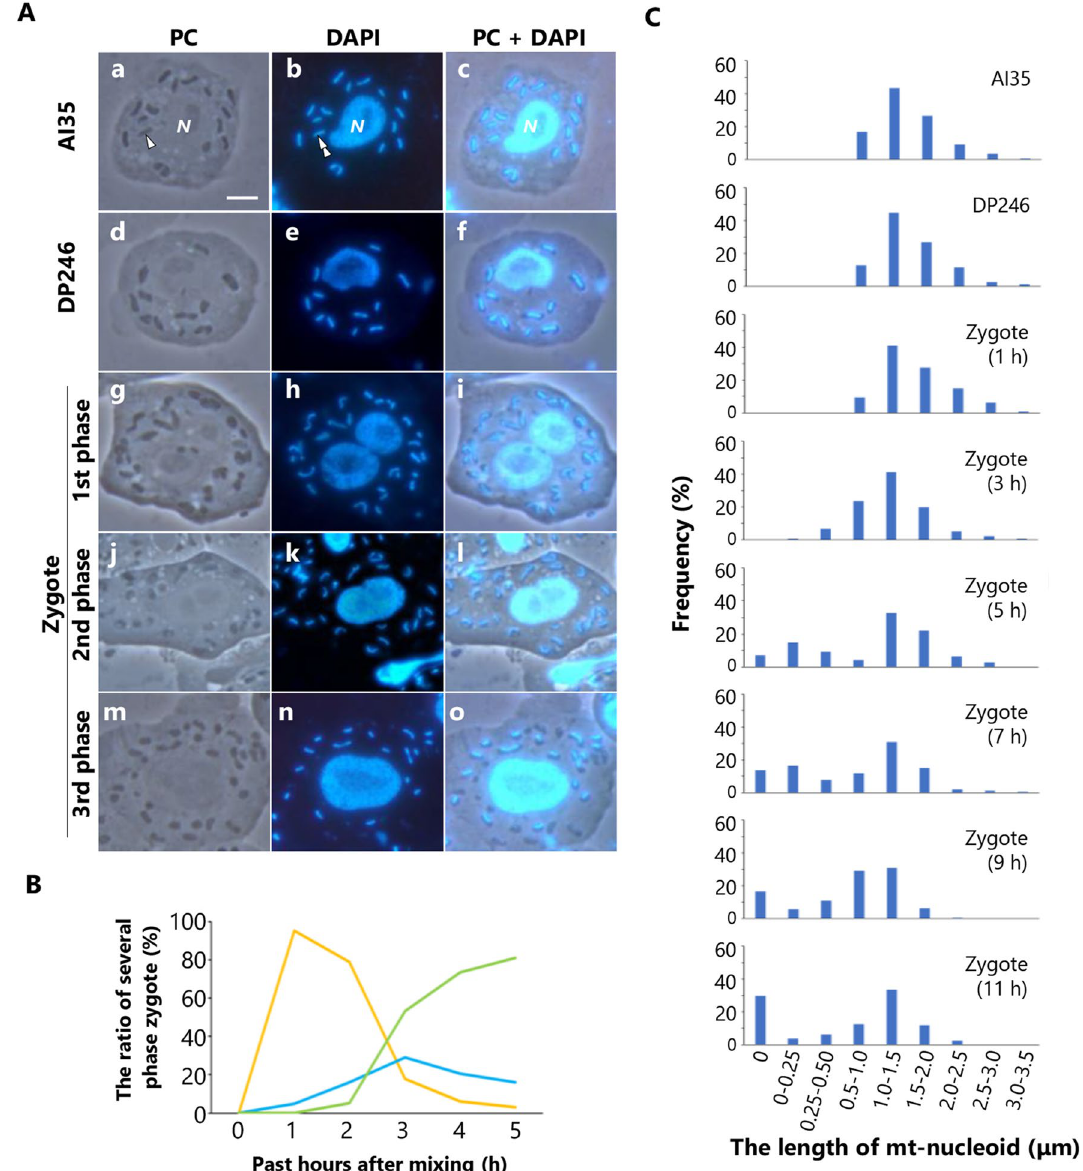
Figure 1. Changes in the mt-nucleoids during zygote maturation in P. polycephalum. ( A ) Microscopic observations of myxamoeba and zygotes in several stages. AI35 ( a – c ), DP246 ( d – f ), zygotes in first phase ( g – i ), zygotes in second phase ( j – l ), and zygotes in third phase ( m – o ) were fixed and stained with DAPI. Phase contrast ( a , d , g , j, and m ), DAPI ( c , f , i , l, and o ), and merged phase contrast and DAPI images are presented. Arrowhead indicates the mitochondria and double arrowhead indicates the mt-nucleoid. In zygotes in the third phase, several mitochondria had the short length mt-nucleoid. N: cell nucleus. Scale Bar = 5 μm. ( B ) Time course of the ratio of the zygotes in each phase. In the first phase (orange), each zygote had two nuclei. In the second phase (blue), two nuclei were fused, and each zygote had a nucleus with two nucleoli. In the third phase (green), two nucleoli were fused and each zygote had a nucleus with a nucleolus. Time (h) represents hours after plating. 1 h: n = 269, 2 h: n = 213, 3 h: n = 180, 4 h: n = 184, and 5 h: n = 168. ( C ) Change in the length of mt-nucleoids during zygote maturation. The length of mt-nucleoids in AI35, DP246, and zygotes at 1 h, 3 h, 5 h, 7 h, 9 h, and 11 h after plating were measured. A histogram showed that the ratio of mitochondria with mt-nucleoids of each range of length. AI35: n = 143, DP246: n = 156, zygote (1 h): n = 127, zygote (3 h): n = 136, zygote (5 h): n = 140, zygote (7 h): n = 152, zygote (9 h): n = 175, and zygote (11 h): n =